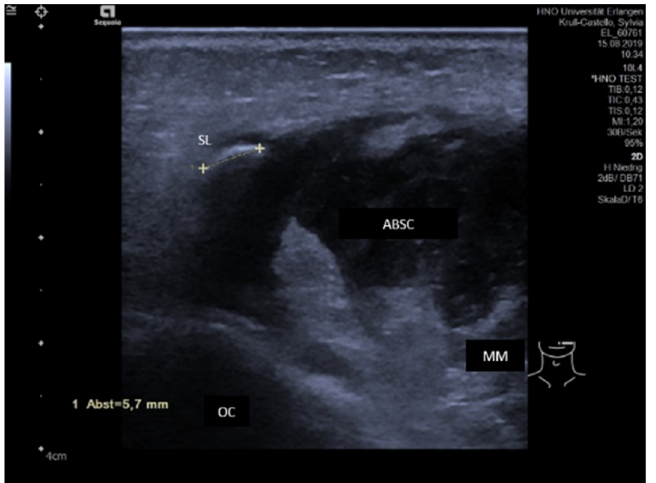
Figure 5. Abscess formation of the left cheek region. The transcervical view to the cheek shows a hypoechoic to anechoic space-occupying lesion overlying the middle and distal part of Stensen’s duct. The formation was irregularly shaped with ill-defined borders and small intra-lesional hyperechoic reflexes representing thick secretion and/or air-producing bacteria. Sialolithiasis is recognized as the main reason and must always be excluded. A sialolith was also visible in this case characterized by a hyperechoic reflex measuring 5.7 mm (dotted line). Abbreviations: MM, masseter muscle; OC, oral cavity, SL, sialolith; ABSC, abscess.